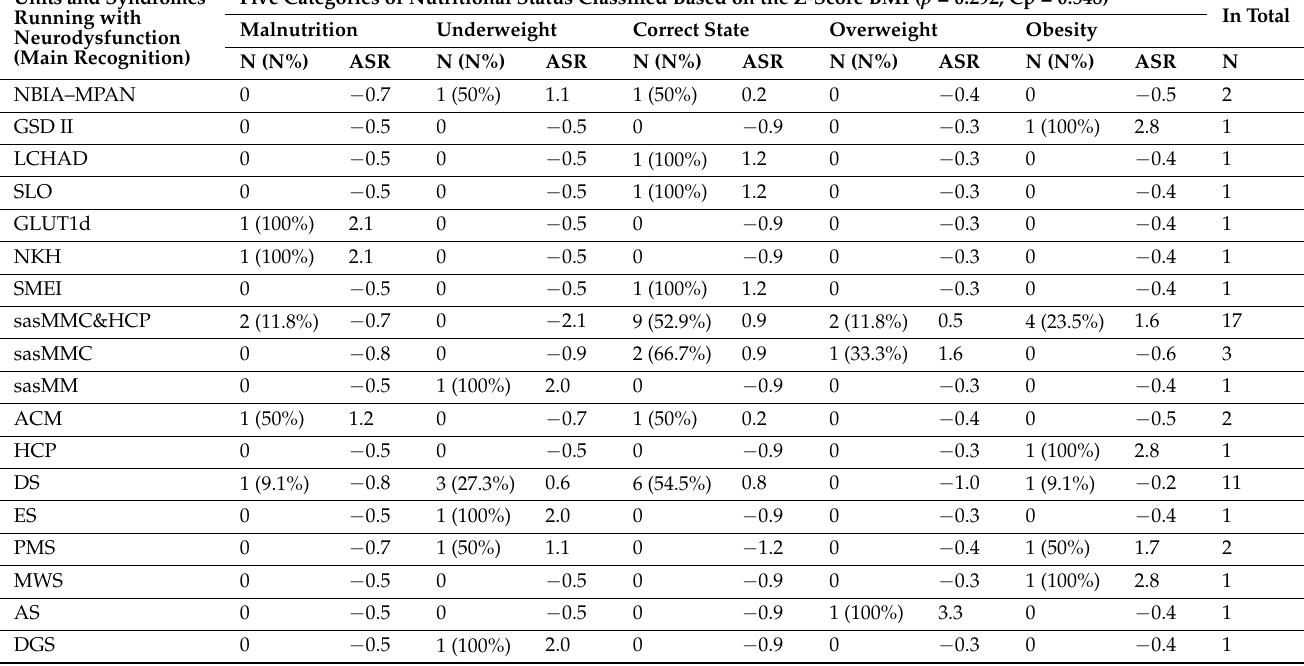
Table 5. Relationship between five categories of nutritional status classified based on the BMI z-score and units and syndromes running with neurodysfunction. Units and Syndromes Running with Neurodysfunction (Main